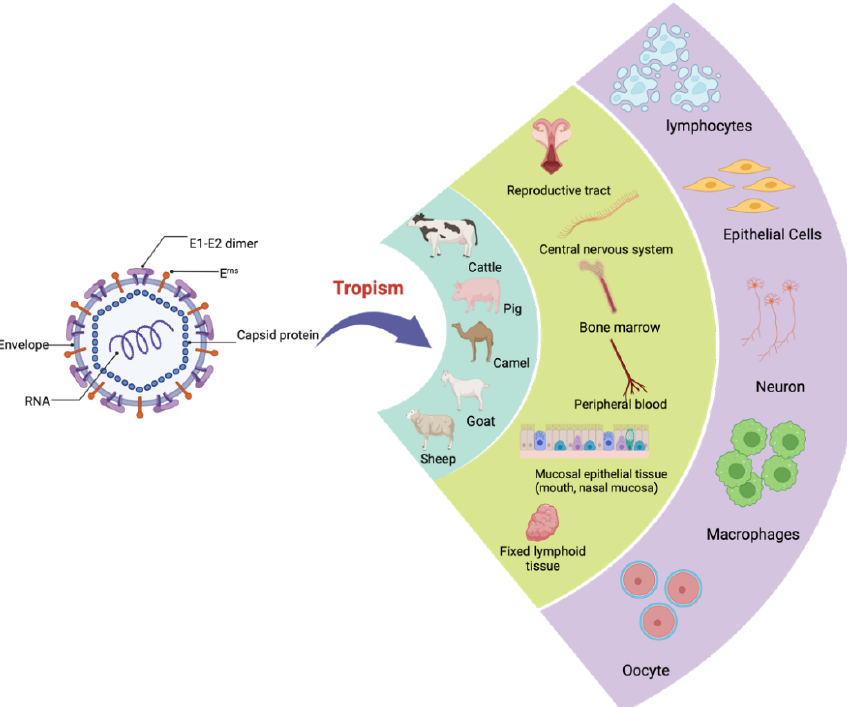
Figure 1. The morphology and tropism of BVDV. An illustration of the BVDV particle shows the morphology and tropism of the virus. Capsid proteins enclose viral RNA. The outer viral envelope protein contains E rns and E1-E2 heterodimers, which are required for the virus entry. BVDV can infect a variety of animals (such as cattle, pig, camel, goat, and sheep) with a wide range of multi-tissue tropism (reproductive tract, central nervous system, bone marrow, peripheral blood, mucosal epithelial tissue and lymphoid tissue). Lymphocytes, epithelial cells, neurons, oocytes and macrophages are common susceptible cells.